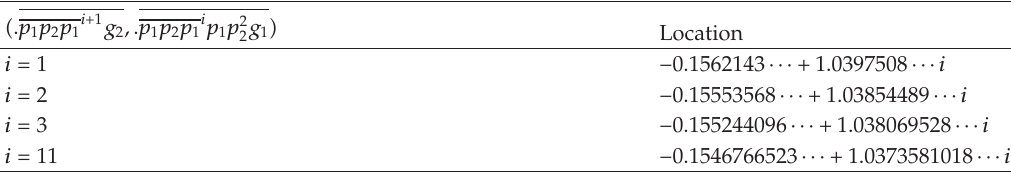
Table 4: Location of canonical triple-spiral medallions.